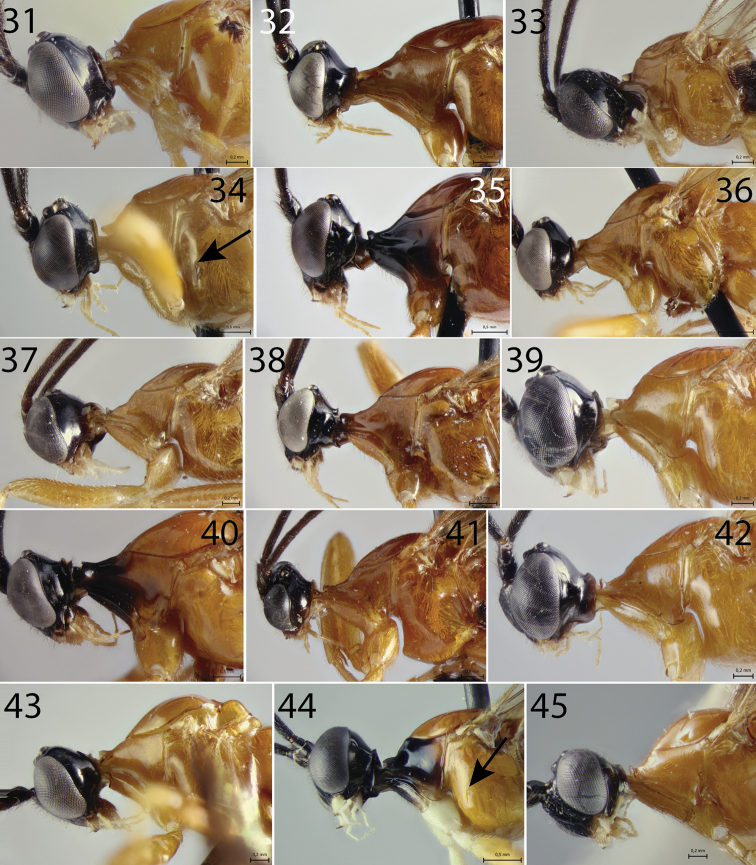
Head and part of mesosoma of Hymenoepimecis spp. (females), lateral view 31H.
andina sp. nov. (holotype) 32H.
bicolor33H.
castilloi sp. nov. (holotype) 34H.
dolichocarinata sp. nov. (holotype), arrow shows the epicnemial carina 35H.
duckensis36H.
ecuatoriana sp. nov. (holotype) 37H.
kleini38H.
longilobus sp. nov. (holotype) 39H.
manauara40H.
neotropica41H.
pucallpina sp. nov. (holotype) 42H.
rafaelmartinezi sp. nov. (holotype) 43H.
ribeiroi44H.
tedfordi, arrow shows the epicnemial carina 45H.
uberensis.